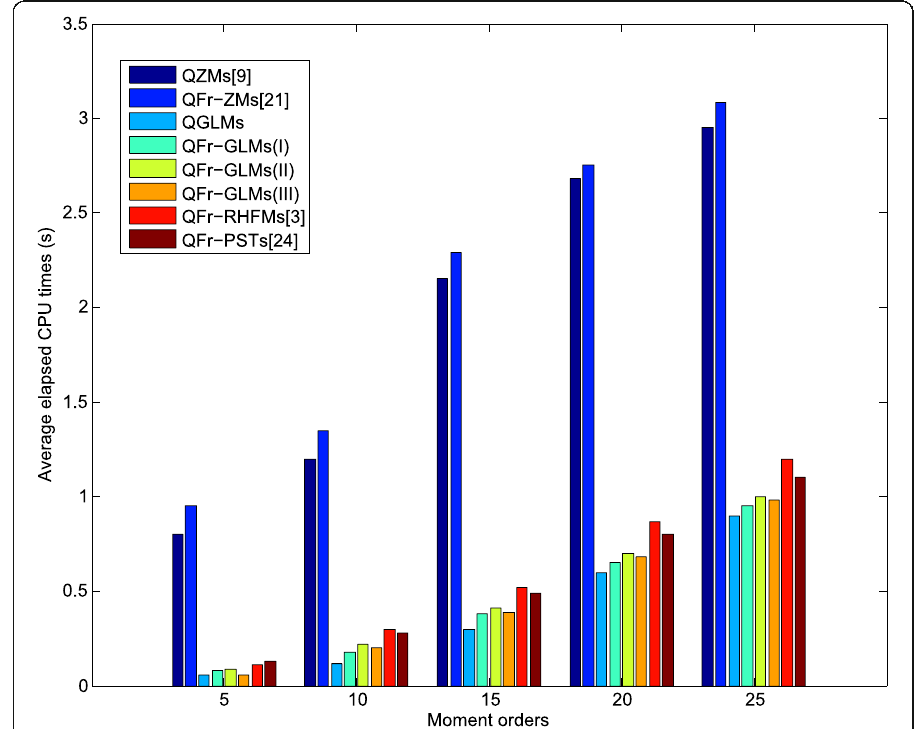
Fig. 14 Average elapsed CPU times of six kinds of orthogonal image